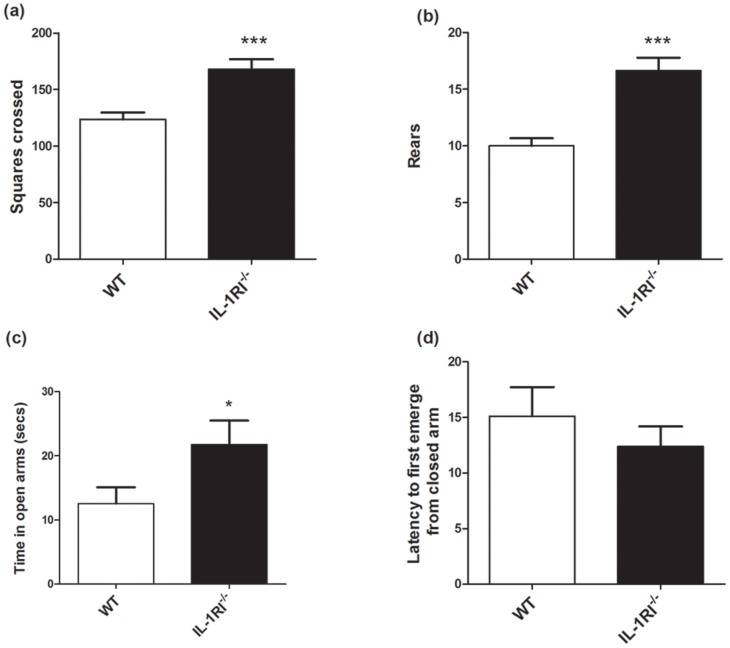
Open field and elevated plus maze activity in IL-1R1−/− and WT mice.(a) Distance travelled in open field in IL-1R1−/− mice (n = 11) compared to WT (n = 19) and (b) the number of rears recorded in open field, across 3 minutes. (c) The time spent in open arms of elevated plus maze and (d) the latency to first emerge from closed arm. Data are expressed as mean ± SEM and significant differences by t -test are denoted by ***p<0.0001 and *p<0.05.